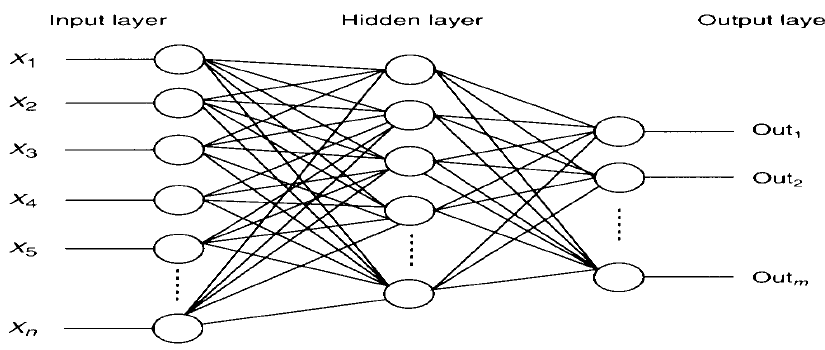
Figure A2. The general structure of a neural network, showing the inputs, input layer, hidden layers and output layer.